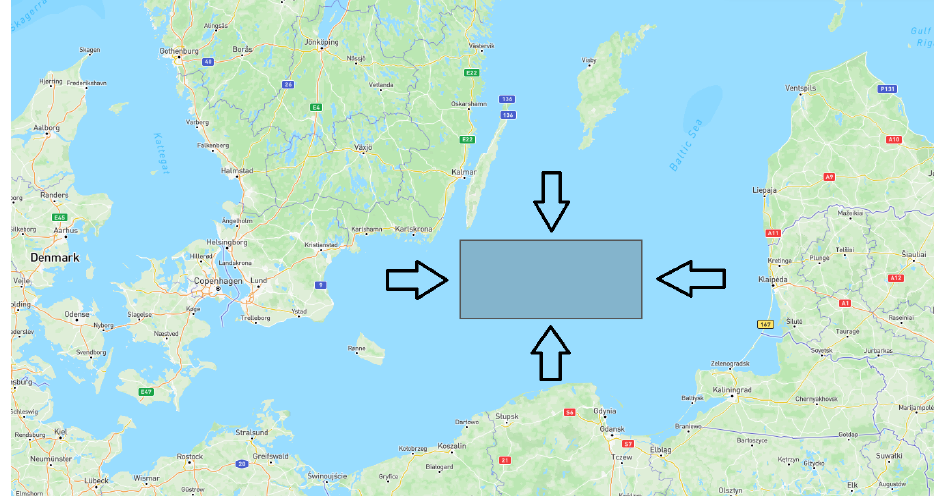
Figure 14. Gray rectangle shows the location of research area on the